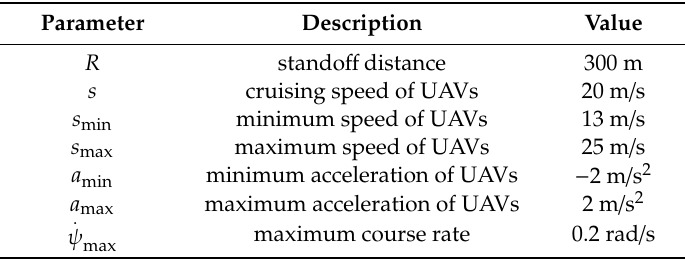
Table 1. Key parameters in the numerical simulation.